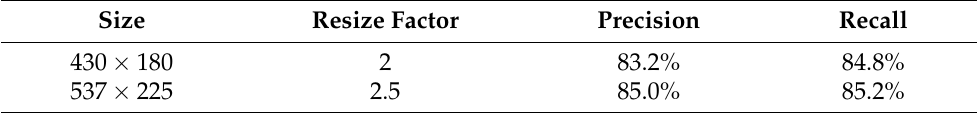
Table 3. Model results with upsampled images.